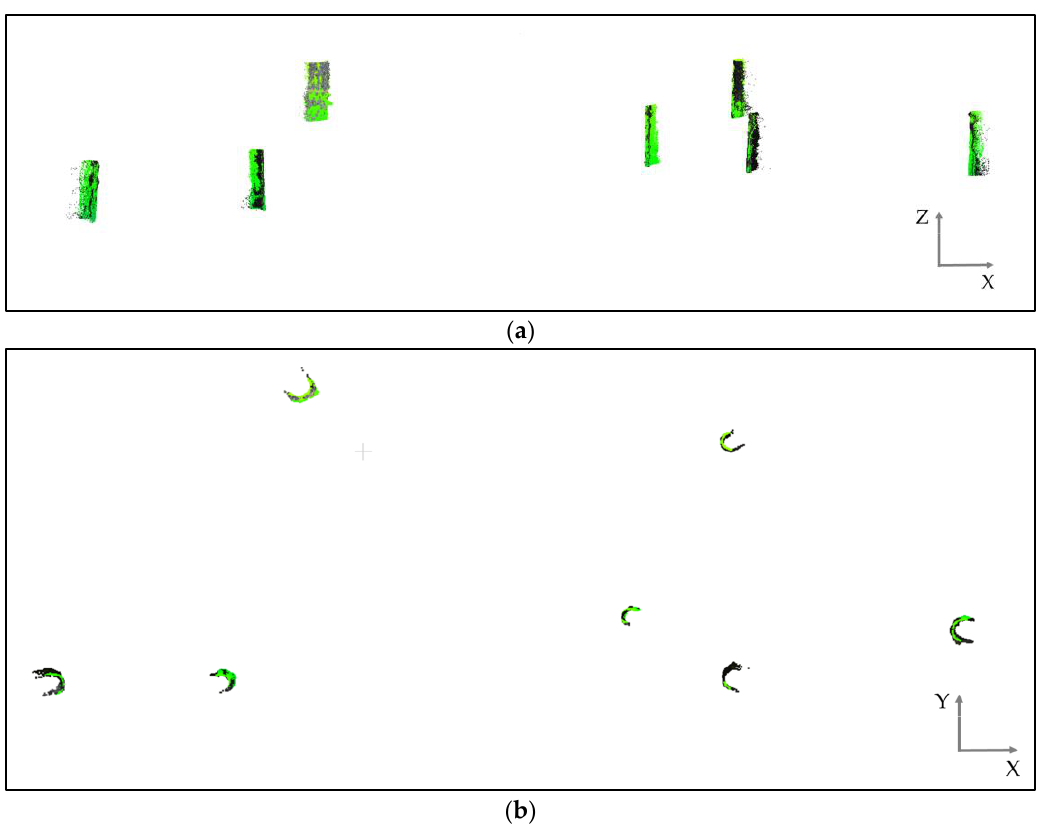
Figure 6. ( a ) Trunk sections extracted from the two point clouds; ( b ) Circumferences of the seven trunks in both point clouds.